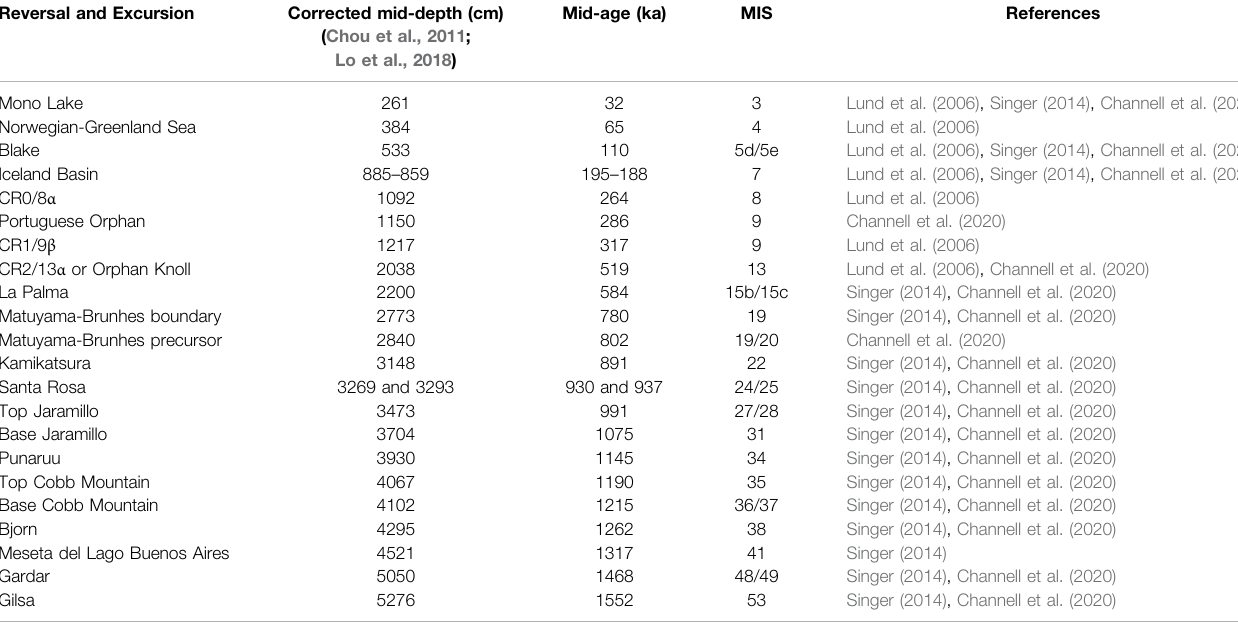
TABLE 1 | Age estimates (ka) for fi eld reversals and geomagnetic excursions of MD01-2414 paleomagnetic record. Reversal and Excursion Corrected mid-depth (cm) (Chou et al., 2011; Lo et al.,